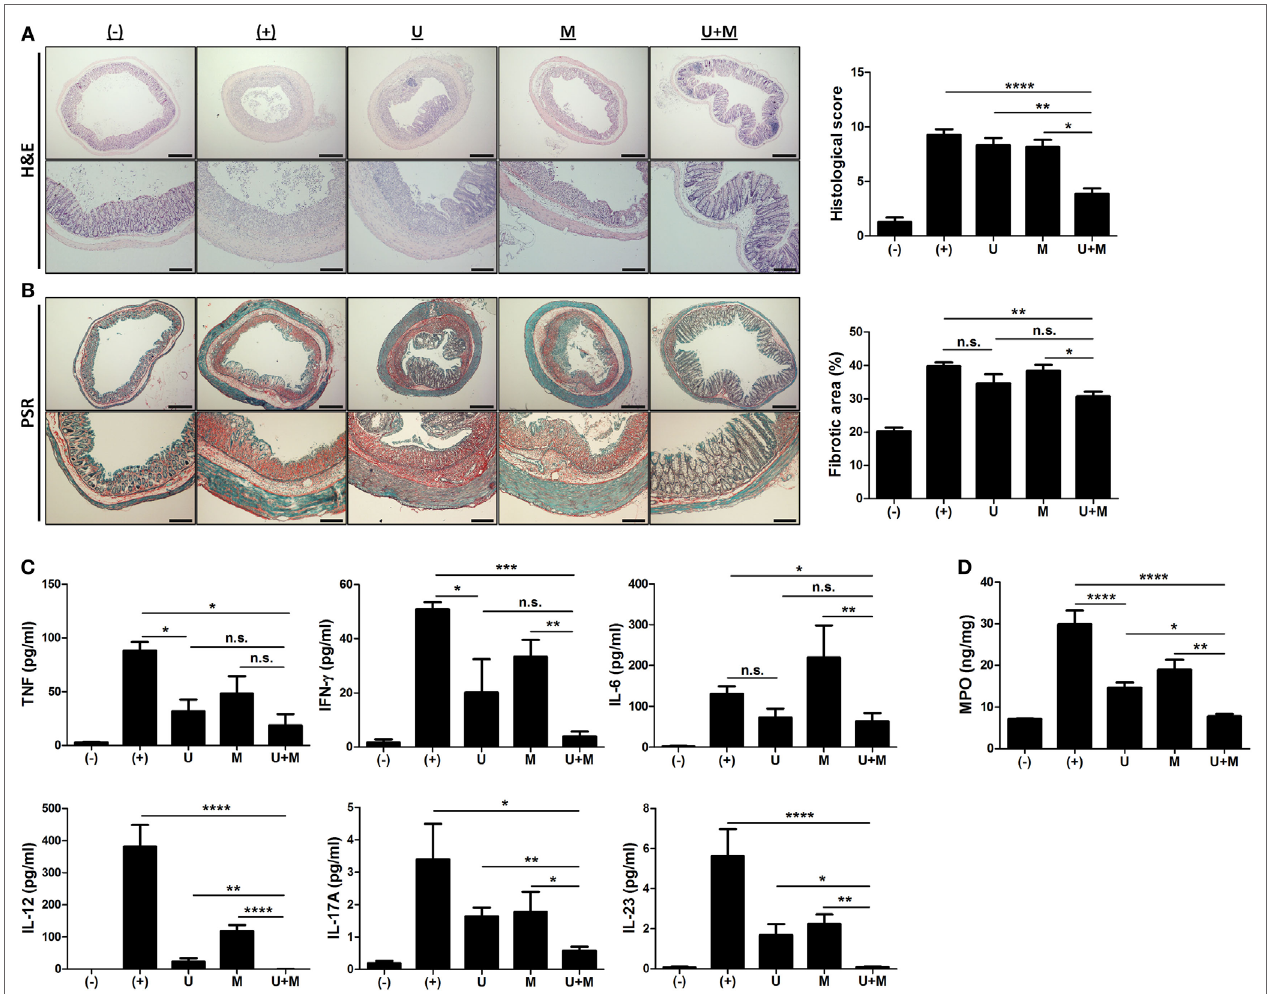
FigUre 2 | Co-administration of MIS416 and human adult stem cells, including umbilical cord blood-derived mesenchymal stem cells (hUCB-MSCs) attenuates inflammation and fibrosis in mice (a) Left: representative images of hematoxylin and eosin-stained sections, bar = 500 µm (upper), 200 µm (lower). Right: histopathological scoring was performed based on the evaluation criteria. (B) Left: representative images of picrosirius red-stained sections, bar = 500 µm (upper), 200 µm (lower). Right: the fibrotic areas were quantified. (c) The levels of tumor necrosis factor (TNF), interferon (INF)- γ , IL-6, IL-12, IL-17A, and IL-23 in the serum of mice were evaluated on day 11 by CBA. (D) Myeloperoxidase (MPO) activity of colon was measured as an indicator for neutrophil infiltration. n = 10–22 mice per group, three independent animal experiments were performed. ( − ): negative control group, ( + ): DSS administered group, U: hUCB-MSCs-treated group, M: MIS416-treated group, U + M: hUCB-MSCs and MIS416 co-treated group. * P < 0.05, ** P < 0.01, *** P < 0.001, and **** P < 0.0001. Results are shown as the mean ±